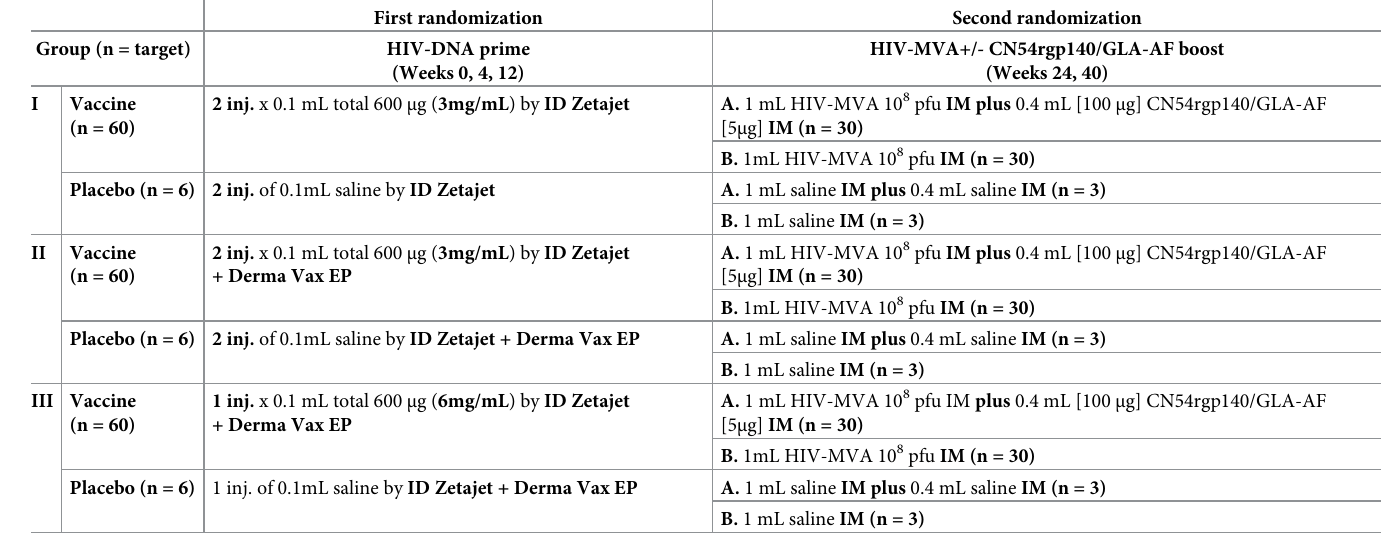
Table 1. Randomized study groups, doses, routes and time-points of different HIV-DNA priming (1 st randomization) and HIV-MVA with or without CN54rgp140/GLA-AF boosting (2 nd randomization) vaccinations. First